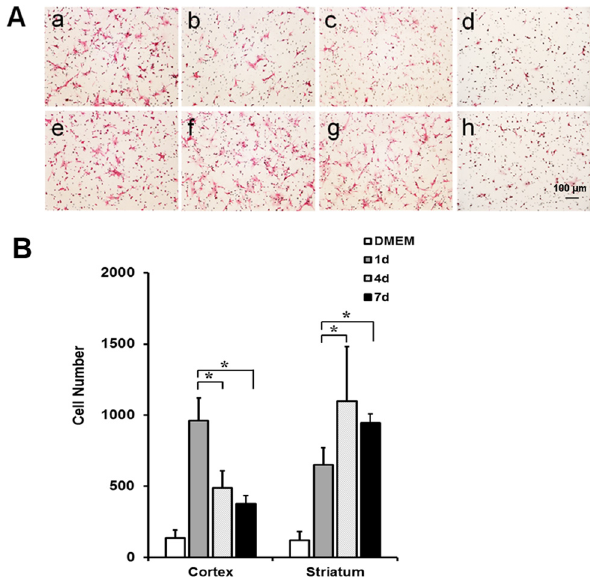
Fig 4. In vitro migration assay using a transwell system with brain extracts obtained from cortex and striatum at 1, 4, and 7 days after MCAo. (A and B) Transwell migration of MSCs with brain extracts obtained from ischemic region (a-c and e-f) was more prominent than without brain extract (d and h). Transwell migration of MSCs was more prominent with brain extract obtained from cortex at 1 day after MCAo (a) than with those obtained at 4 (b) or 7 (c) days after MCAo. However, transwell migration with brain extract obtained from striatum at 1 day after MCAo (e) was lower than with those obtained at 4 (f) or 7 (g) days after MCAo ( * P < 0.05) (n = 5 for each time point). MSCs indicates mesenchymal stem cells; MCAo, middle cerebral artery occlusion.